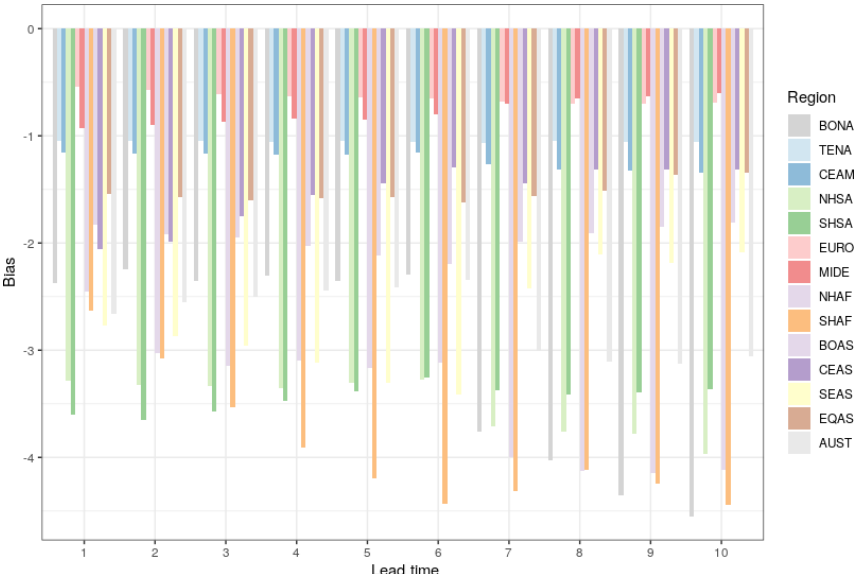
Figure 5. Mean forecast bias as a function of lead times and clustered by GFED macro-regions. The forecast bias for 2017 is assessed using the ensemble mean against the ERA5-based FWI database.